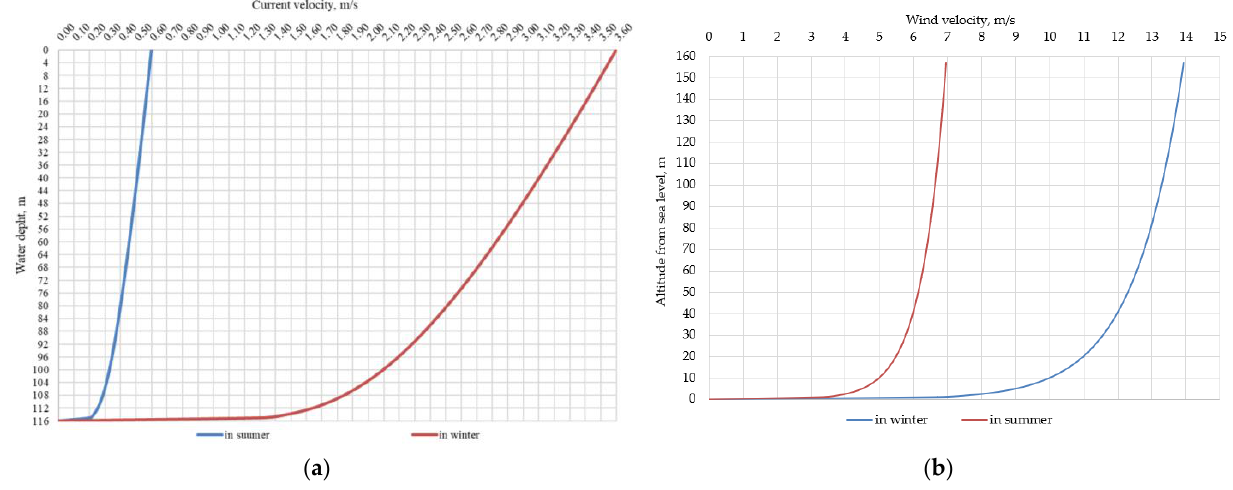
Figure 7. The distribution profile: ( a ) Current velocities; ( b ) Wind velocities.